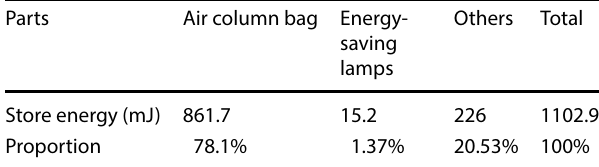
Table 2 Initial inflation pressure: 20